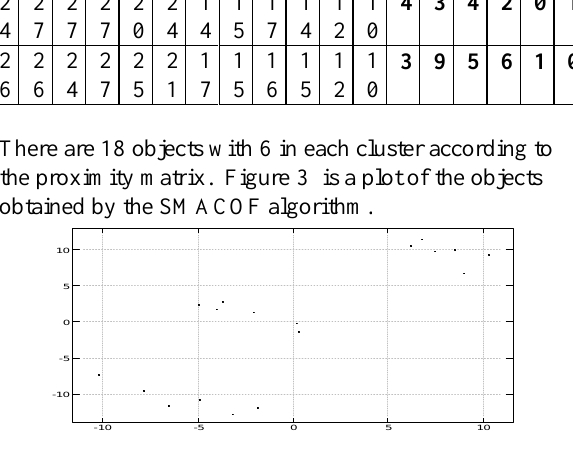
Figure 3 Plot of points corresponding to objects with similar inter object distances as in proximity matrix 3 Both the proximity data and the visual representation show 3 distinct clusters that we will number 1,2, and 3 from the bottom left corner to the top right corner. A fuzzy membership matrix should show the following properties to match the visual representation. Members of visual cluster 1 should show a very dominant membership in that cluster and a small membership in